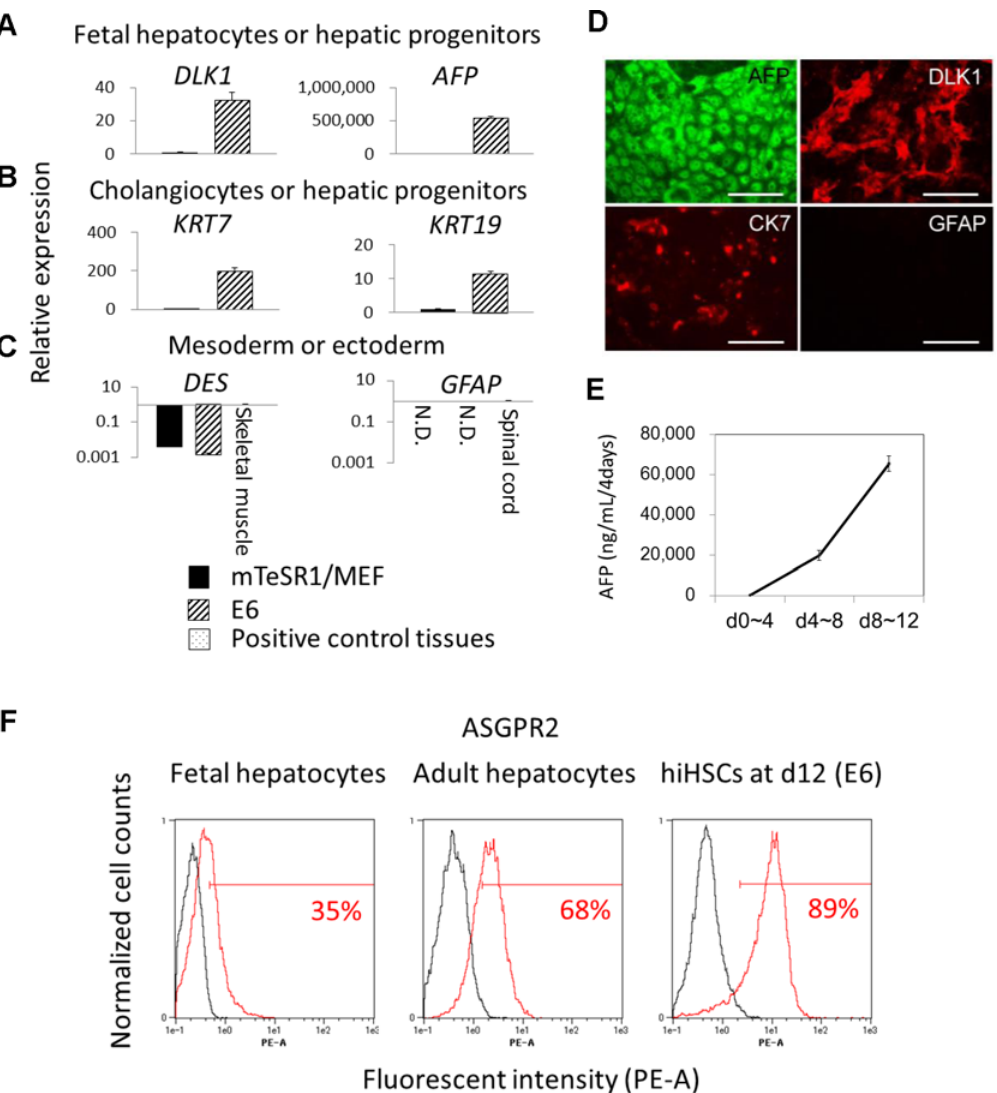
Fig 4. Preferential hepatic specification of hiHSCs in Essential 6 medium. Self-renewing hiHSCs (clone AFB1-1) preferentially orient toward hepatic specification in Essential 6 medium without any exogenous differentiation factors. See also Fig 3. ( A – C ) Gene expression was analyzed by quantitative RT-PCR. ( A ) DLK1 and AFP , ( B ) KRT7 and KRT19 , and ( C ) DES and GFAP are shown as gene symbols. Total RNAs of human skeletal muscles and spinal cords were utilized as positive controls for the expression of DES and GFAP , respectively. Data are presented as mean+SEM and represent a minimum of three independent samples with at least two technical duplicates. ( D ) Immunofluorescent staining for AFP, DLK1, CK7, and GFAP. Scale bar represents 100 μ m. ( E ) Release of AFP was measured by ELISA at three time points. Data are presented as mean ± SEM and represent a minimum of three independent samples with at least two technical duplicates. See also Table 1. ( F ) Flow cytometry analyses of ASGPR2-positive cells. Data are presented as the mean and represent a minimum of three independent